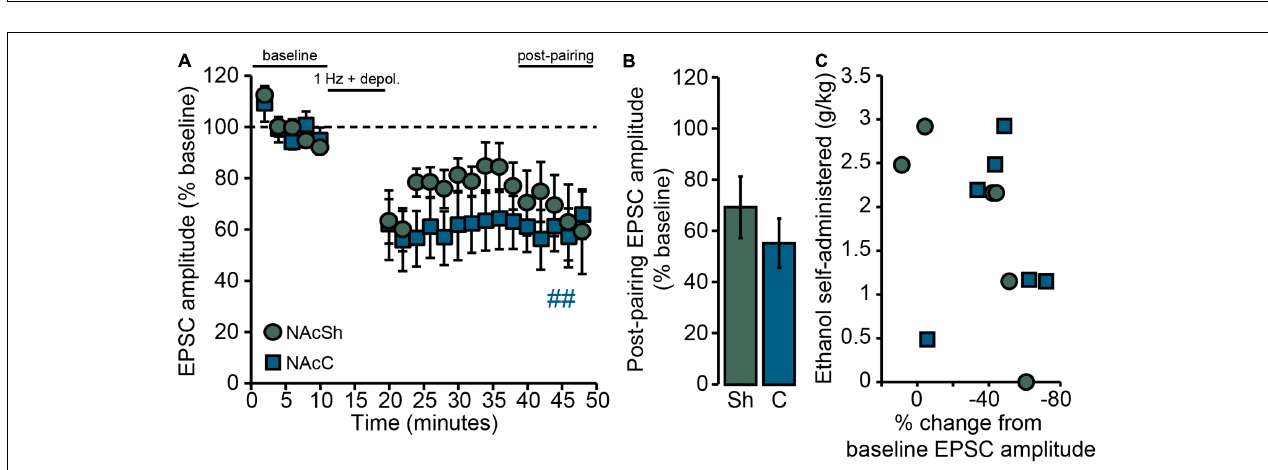
FIGURE 4 | NAcSh D1MSN LTD is attenuated by pharmacological inhibition of ALK. (A) Data points are group means ( ± SEM) for normalized (% baseline) EPSC amplitudes averaged in 2-min bins; vehicle (0 nM: n = 6 cells, six mice; 5 nM TAE684: n = 4 cells, three mice; 25 nM TAE684: n = 4 cells, three mice). In the vehicle group alone, evoked EPSC amplitudes during the 40–50 min “post-pairing” period were significantly reduced relative to baseline. ## p = 0.0003, post-pairing vs. baseline period (simple effect of pairing in vehicle group). (B) Bars show group means ( ± SEM) for normalized EPSC amplitudes averaged over the entire 10-min post-pairing period. 25 nM TAE684 was significantly different from 0 nM ( ∗ p = 0.02), while 5 nM TAE684 was not different from either concentration (Bonferroni post hoc comparisons). (C) Representative traces of evoked EPSCs during the baseline and post-pairing periods.